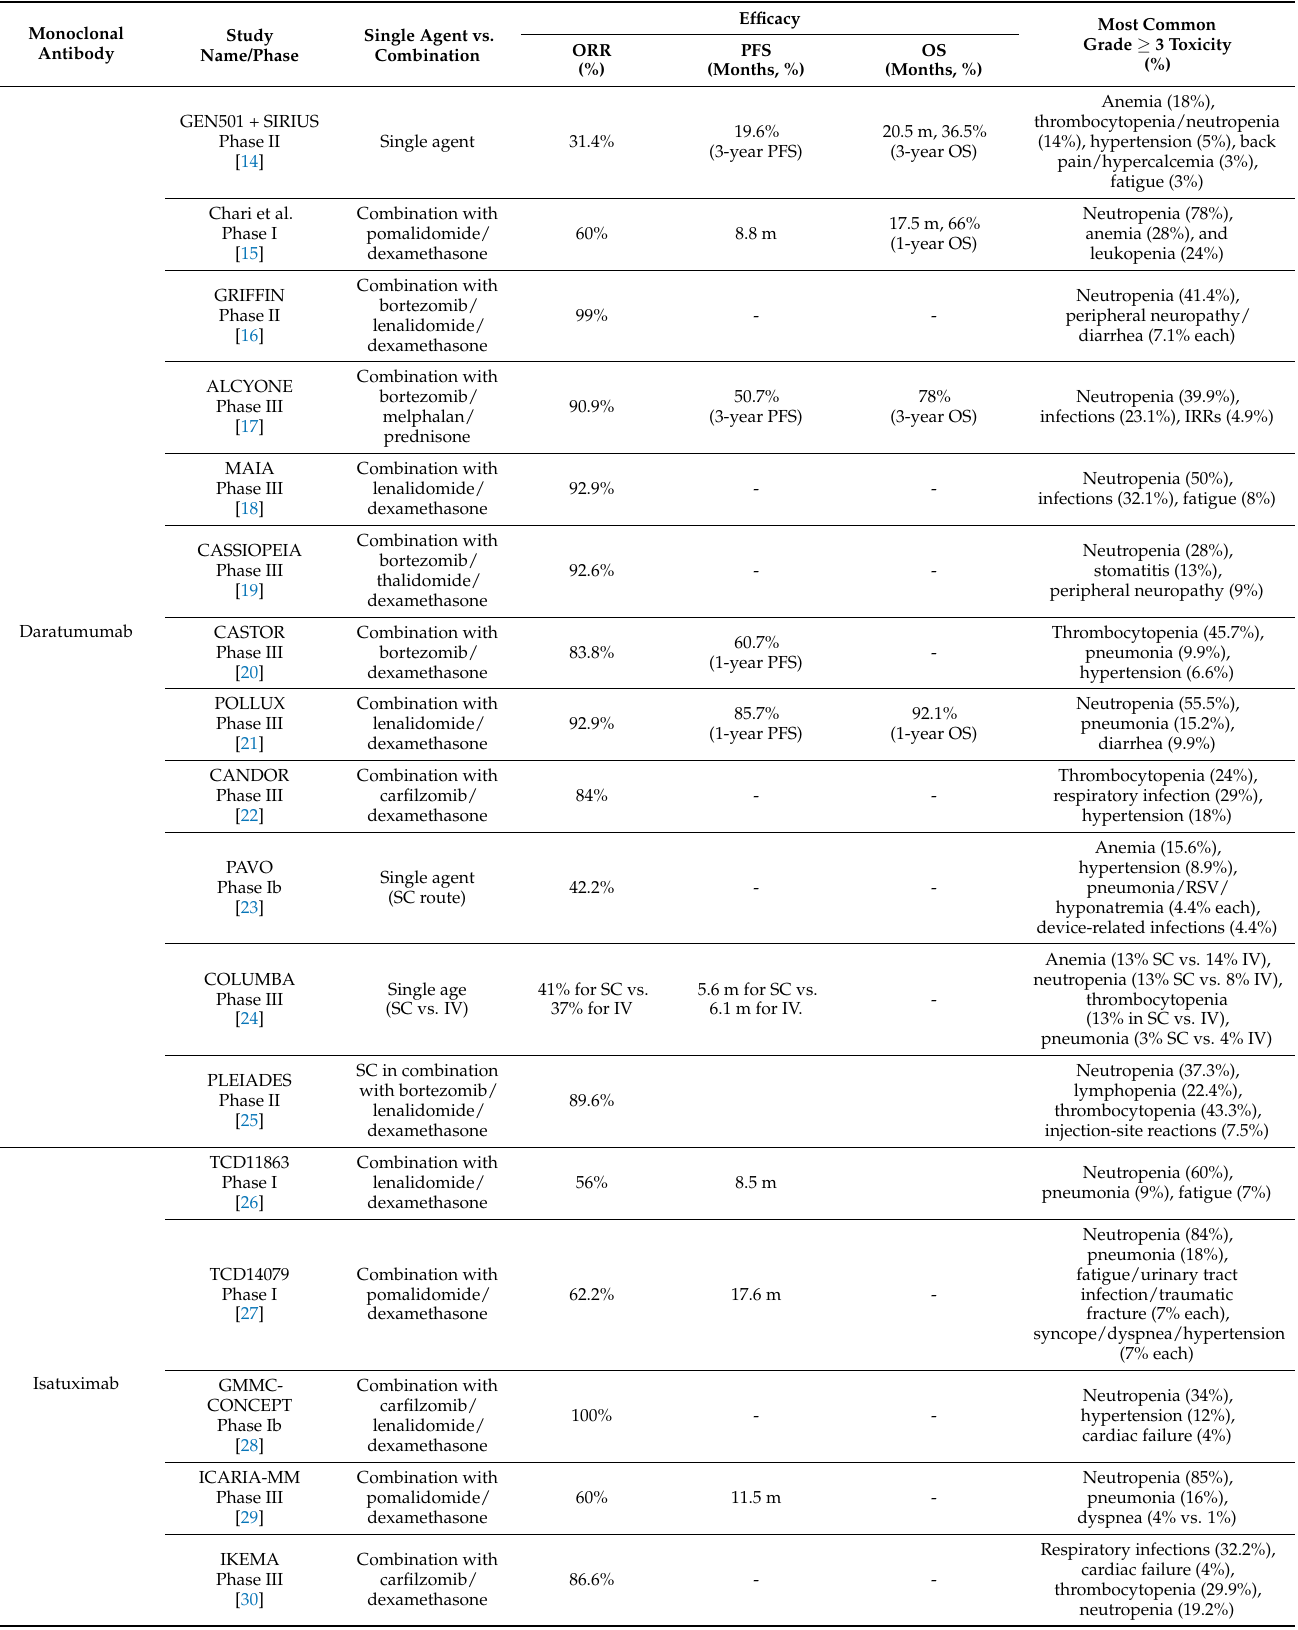
Table 1. Monoclonal antibody summary of efficacy and grade 3 adverse events for the treatment of multiple